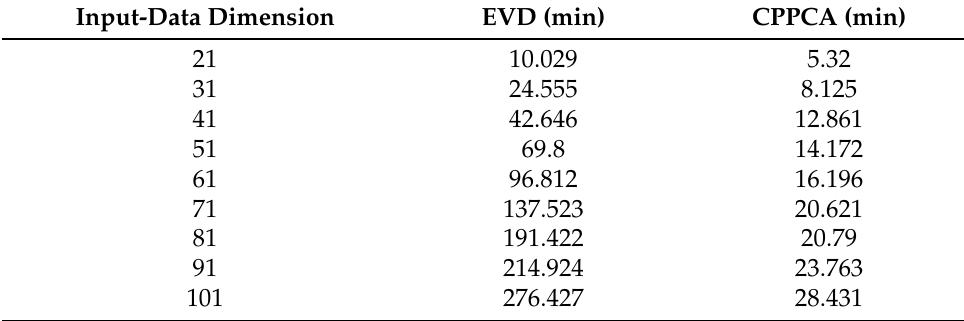
Figure 6. The reconstructed interferograms from the EVD method ( a ) and the CPPCA method ( b ) under different SAR stack dimensions. The corresponding difference maps are listed in ( c ). Table 1. The execution times required by the EVD and the CPPCA methods under different SAR stack